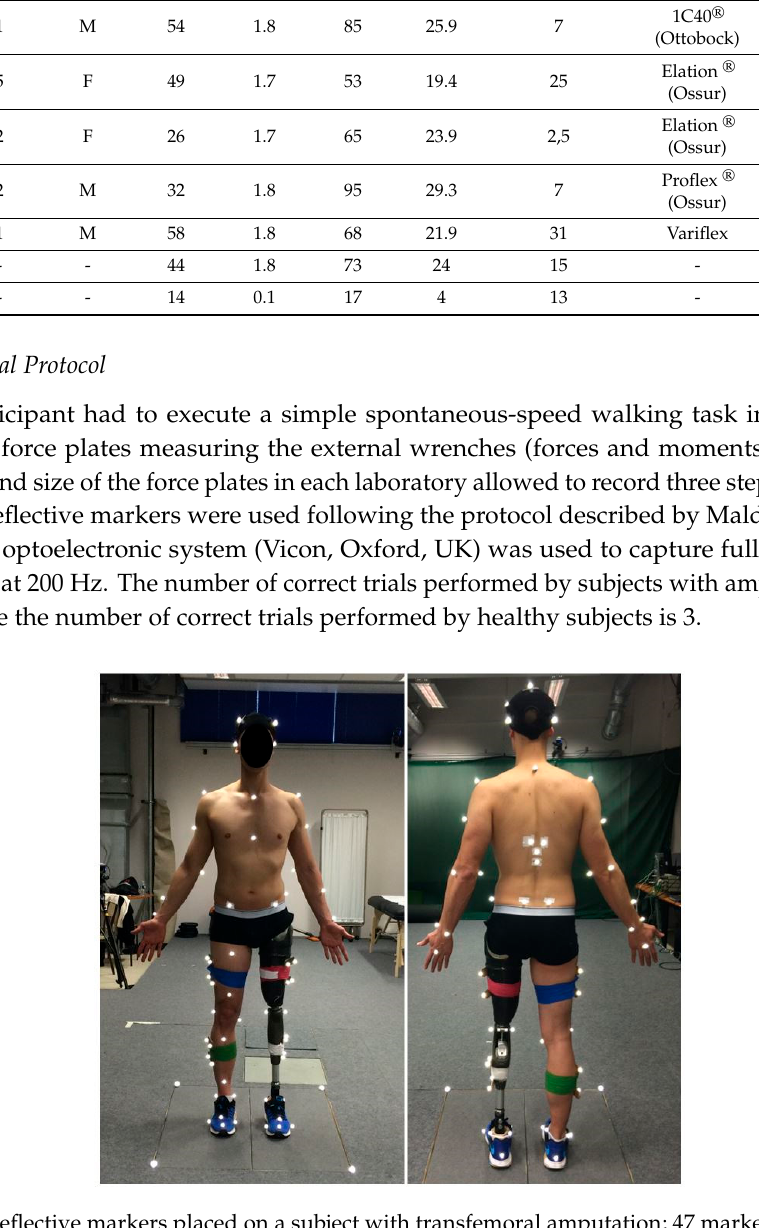
Figure 1. Reflective markers placed on a subject with transfemoral amputation; 47 markers were used in the present study according to the protocol described by Maldonado et al. [15].